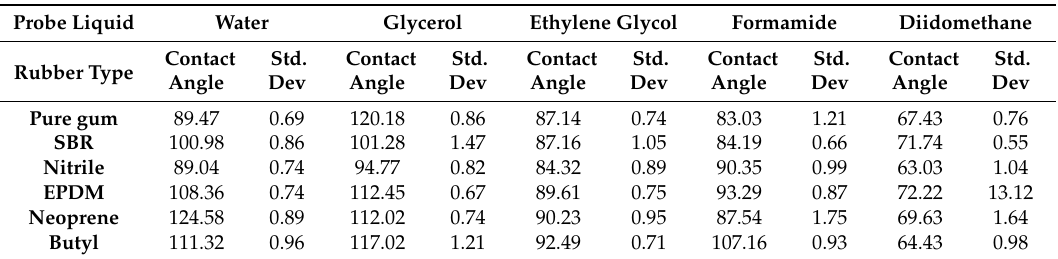
Table 4. Average contact angle between rubbers and probe liquids using Sessile drop device (degrees). Probe Liquid Rubber